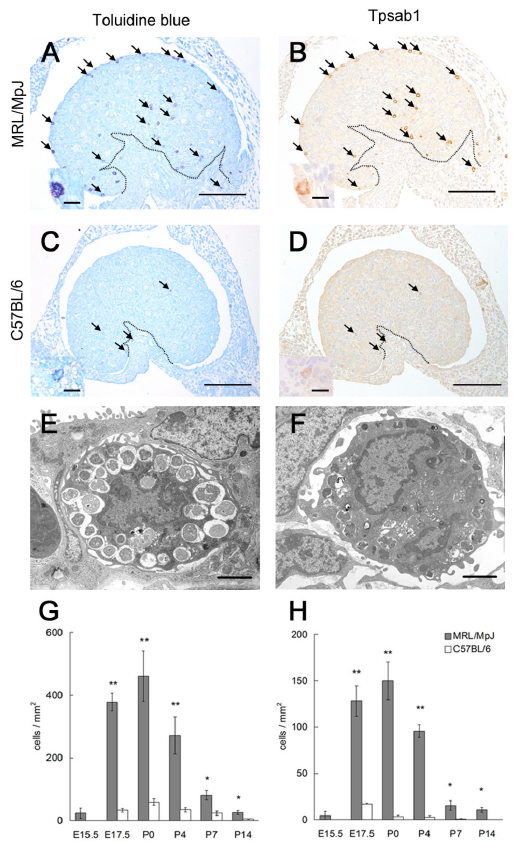
Figure 1. The appearance of mast cells in the ovaries of neonatal mice. (A–D) The ovaries of neonatal mice. Serial sections of mouse ovaries at postnatal day 0 were stained using toluidine blue (panels A and C) or immunohistochemistry for the mast cell (MC) marker Tpsab1 (panels B and D). In MRL/MpJ mice, numerous metachromatic MCs are observed in the cortex of the ovary (panel A, arrows), and these cells are positive for Tpsab1 (panel B, arrows). In C57BL/6 mice, a few metachromatic MCs and Tpsab1-positive cells are identified (panels C and D, arrows). The cytoplasmic granules showing metachromasy and a positive signal for Tpsab1 are more abundant and larger in MRL/MpJ mice than in C57BL/6 mice (panels A–D, insets). Arrows indicate the same cells. Dotted lines indicate the border between the cortex and medulla of the ovary. Bars in panels: 100 µm. Bars in insets: 10 µm. (E and F) The ultrastructure of MCs in mouse ovaries at postnatal day 0. The MCs of MRL/MpJ mice (panel E) have more and larger cytoplasmic granules than the MCs of C57BL/6 mice (panel F). The ovarian MCs have fold-like structures on the cell surface and segmented or non-segmented nuclei in both strains. Bars: 2 µm. (G and H) MC density in mouse ovaries. The number of metachromatic MCs in the whole area of the ovary (panel G) or in the surface epithelial region of the ovary (panel H) was divided by the area of the ovary. Data represent the mean ± SEM (n = 3–6 in each group). Significant differences between MRL/MpJ and C57BL/6 mice were analyzed using the Mann- Whitney U test at each time point. *: P < 0.05, **: P < 0.01. doi: